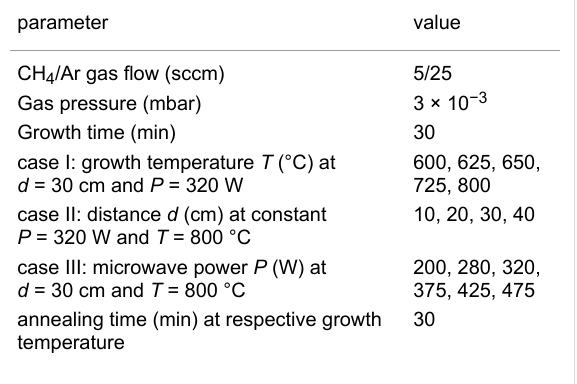
Table 1: Process parameters for VGNs growth by